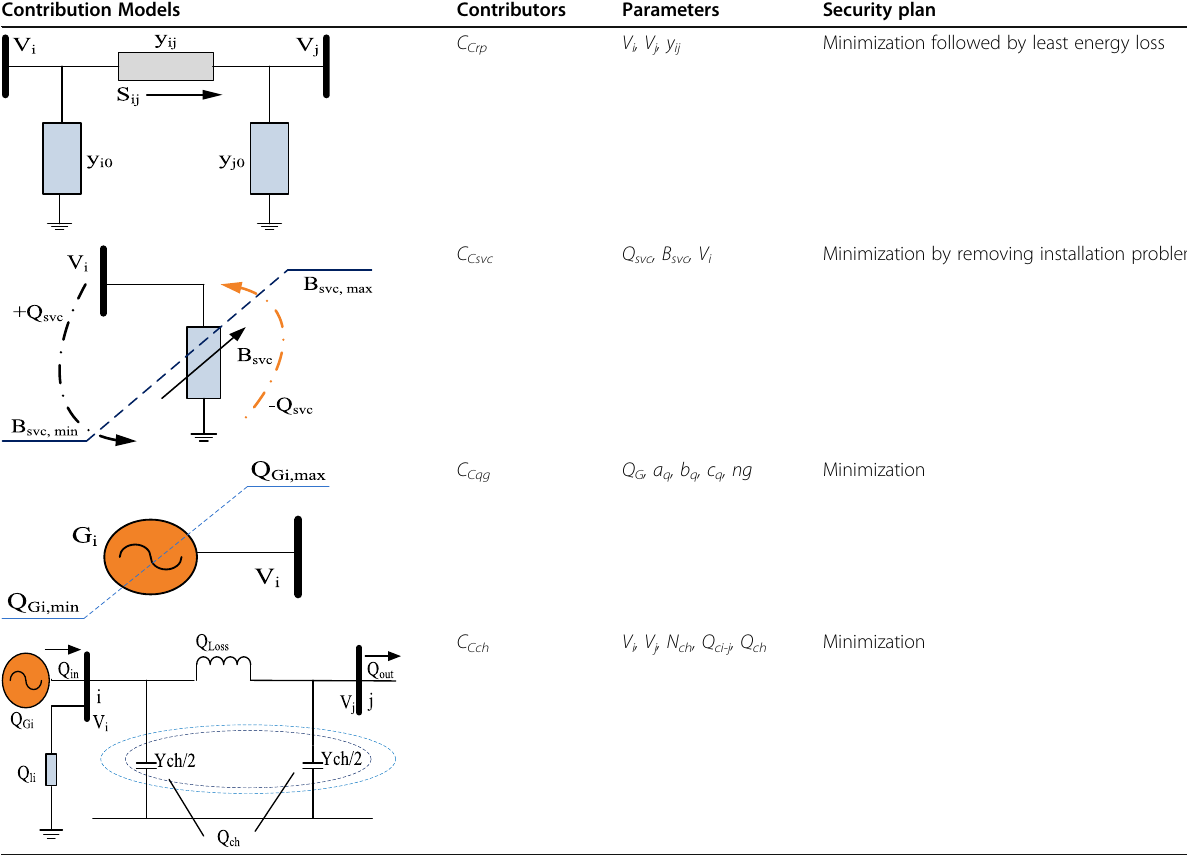
Table 1 Comprehensive representation of cost amalgamated split objective function Contribution